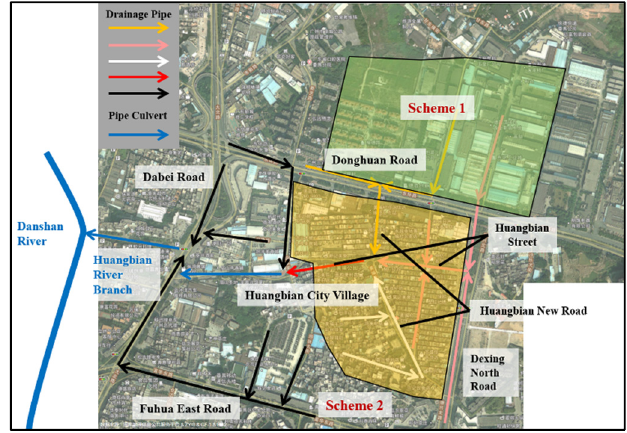
Figure 4. Schematics for Schemes 1 and 2 of impermeability reduction.